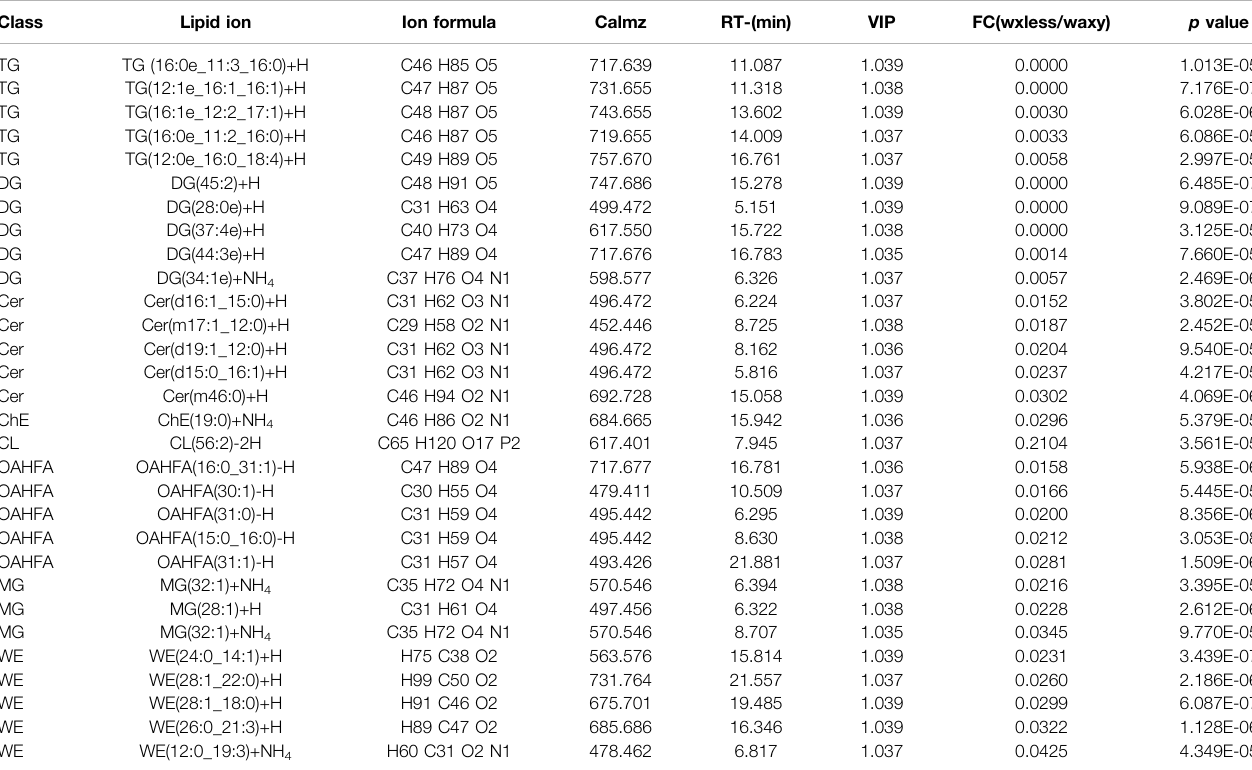
TABLE 1 | Some signi fi cant differences in lipid ions between the two mutants. Class Lipid ion Ion formula Calmz RT-(min) VIP